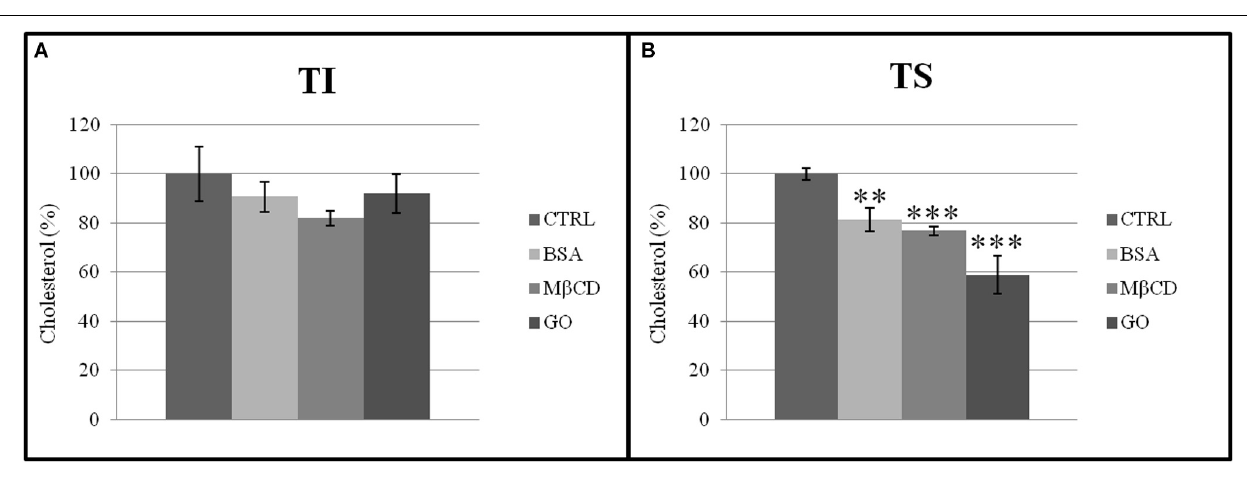
FIGURE 8 | Cholesterol normalized to total protein content in (A) insoluble (TI) and (B) soluble (TS) membrane fractions, isolated from MEF prepared from sperm incubated in a capacitating medium (BSA, M β CD, GO treatments), or from sperm collected in a non-capacitating medium (CTRL). Values were expressed as percentage change relative to control value. Values are means ± SE for three separate experiments. ** p < 0.01 versus control, *** p < 0.001 versus